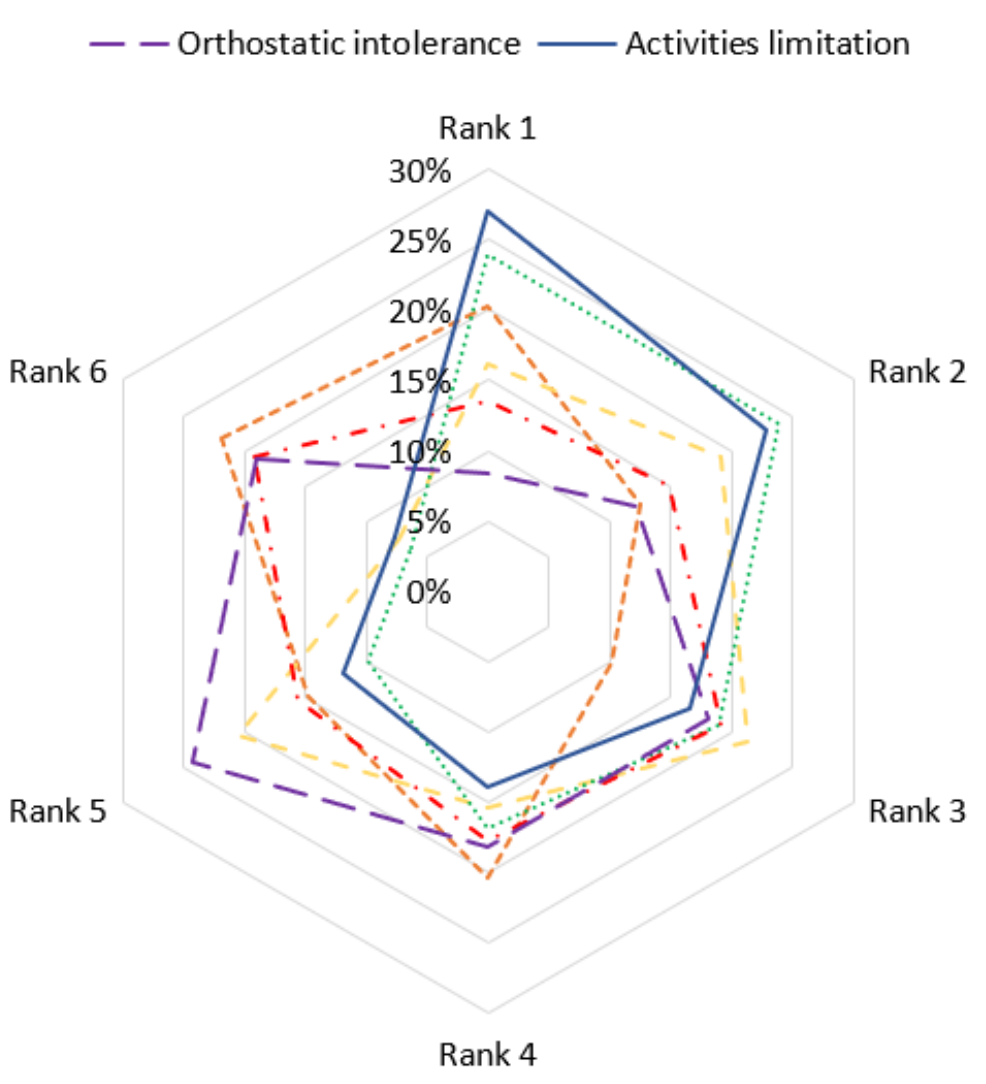
Figure 2. Radar chart of the most disabling symptoms rating for SEID patients.